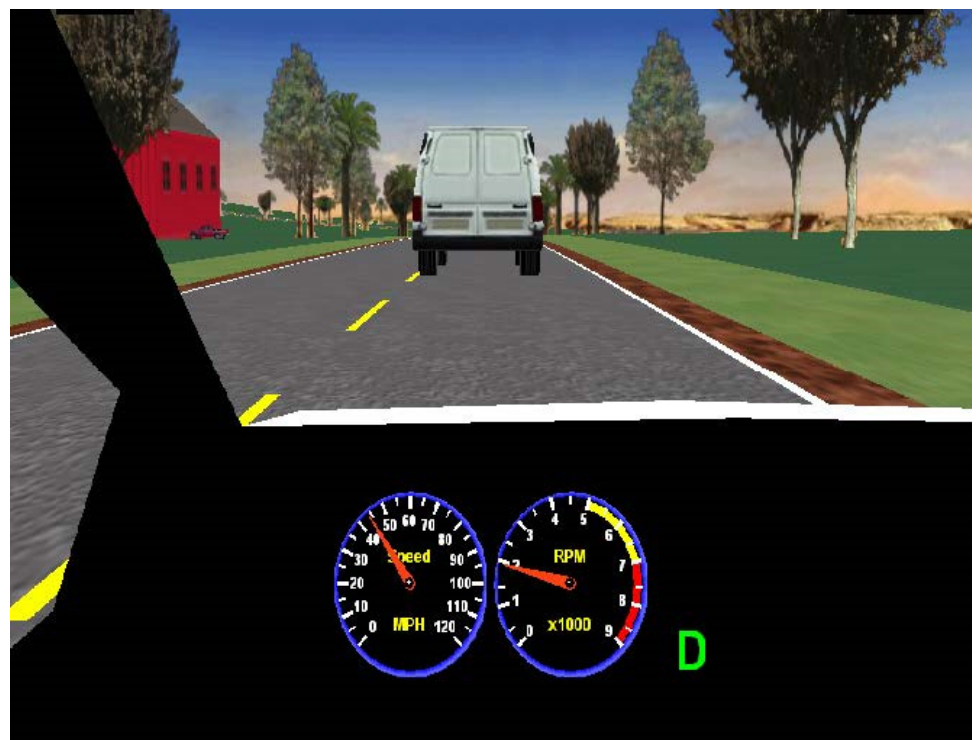
Figure 3. Screenshot of van pulling out in front of driver.